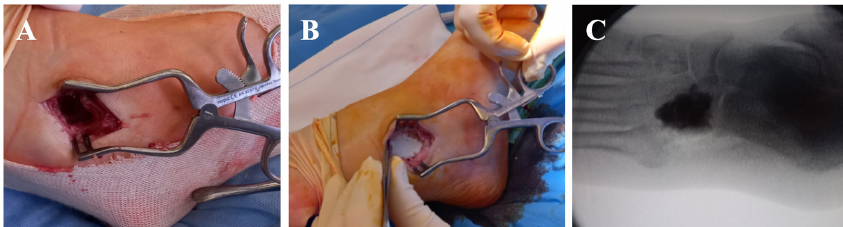
Figure 2. (a) Intraoperative cuboid bone debridement. (b) The medullary defect was filled with absorbable, gentamicin- and vancomycin- loaded, calcium sulfate–hydroxyapatite biocomposites (CERAMENT G and V). (c) An anteroposterior X-ray after